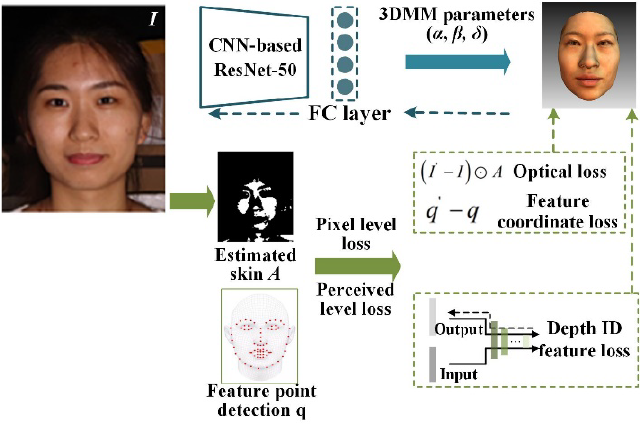
Figure 4. Flow chart of network